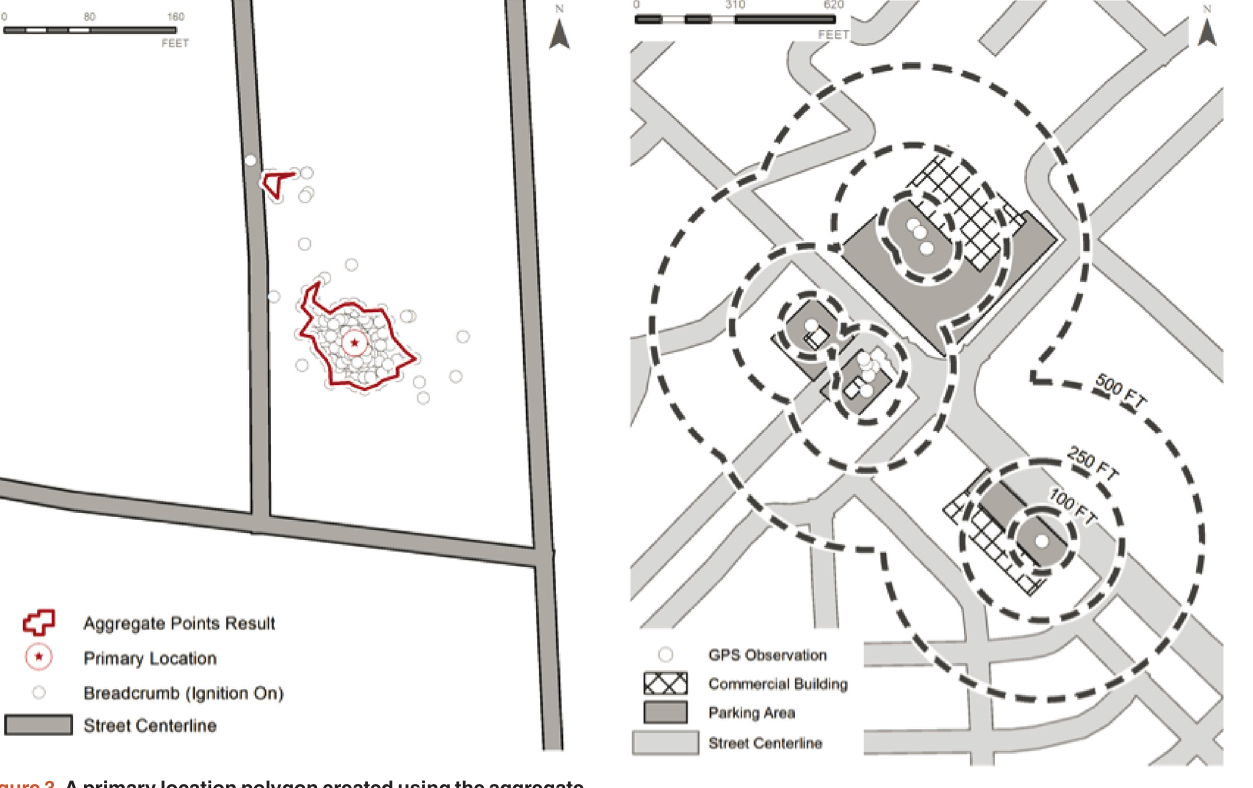
Figure 4. Unique destination sample with multiple